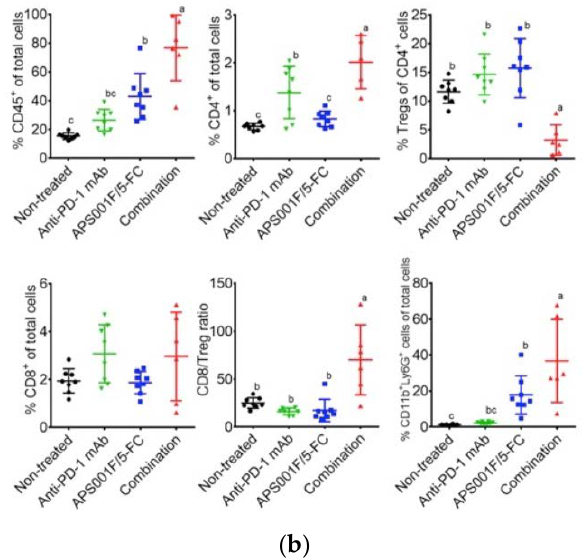
Figure 4. Anti-tumor effects of APS001F/5FC, anti-PD-1 mAb, and their combination were evaluated in a syngeneic CT26 mouse model. Experiment schedule. Mice were s.c. inoculated with 1 × 10 5 CT26 cells (day -13), and stratification was done on day 0. APS001F was administered i.v. at 1.0 × 10 9 c.f.u./mouse via the tail vein on day 3 with 200 mg maltose supplementation (days 3 through 16). 5-FC was administered i.p. at 250 mg/kg twice a day (500 mg/kg/day) on days 5 through 9 and days 12 through 16. Anti-PD-1 mAb was administered i.p. at 200 µg/mouse on days 1, 4, 8, and 11. Tumor volume was measured twice a week. ( a ) Change in tumor volume after treatment with APS001F/5-FC, anti-PD-1 mAb, and their combination. Results are the mean ± standard error of the mean of 9 mice. Analyses of 4 groups on day 21 were conducted using Tukey’s method of multiple comparisons. Means sharing a letter are not significantly different. Tumor Growth Inhibition was calculated on day 21. ( b ) Flow cytometric analysis of tumor cells in mice engrafted with CT26 cells. Results are the mean ± standard deviation of 8 mice. %CD45 + of total cells, %CD4 + of total cells, %Tregs (CD45 + CD4 + CD25 + Foxp3 + cells) of CD4 + cells, %CD8 + of total cells, CD8/Treg ratio, and %neutrophils (CD45 + CD11b + Ly-6G + cells) of total cells, and %TAMs (CD45 + CD11b + Ly-6G − Ly-6C low cells) of total cells were analyzed. Analyses of 4 groups were conducted using Tukey’s method of multiple comparisons. Means sharing a letter are not significantly different. This figure was adopted from a previous study [48].